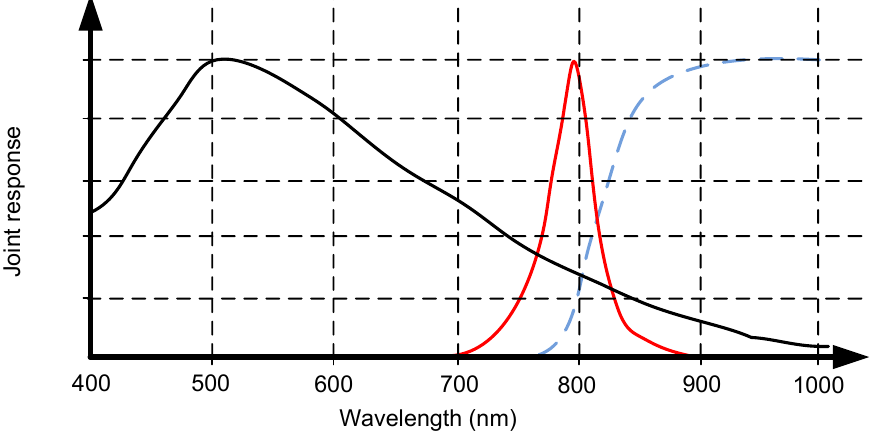
Figure 10. Joint response of the overall system: camera sensor (black solid line), infrared emission (red solid line) and filter transparency (blue dashed